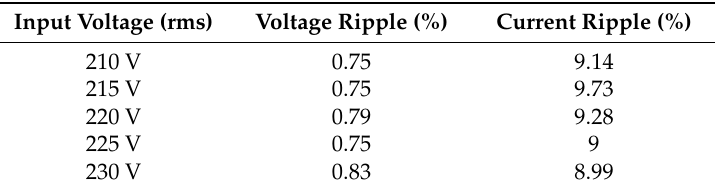
Figure 15. Measured input current harmonics compared with the IEC 61000-3-2 Class C standards. Table 3. Measured output voltage ripple and current ripple in the presented LED streetlight driver.